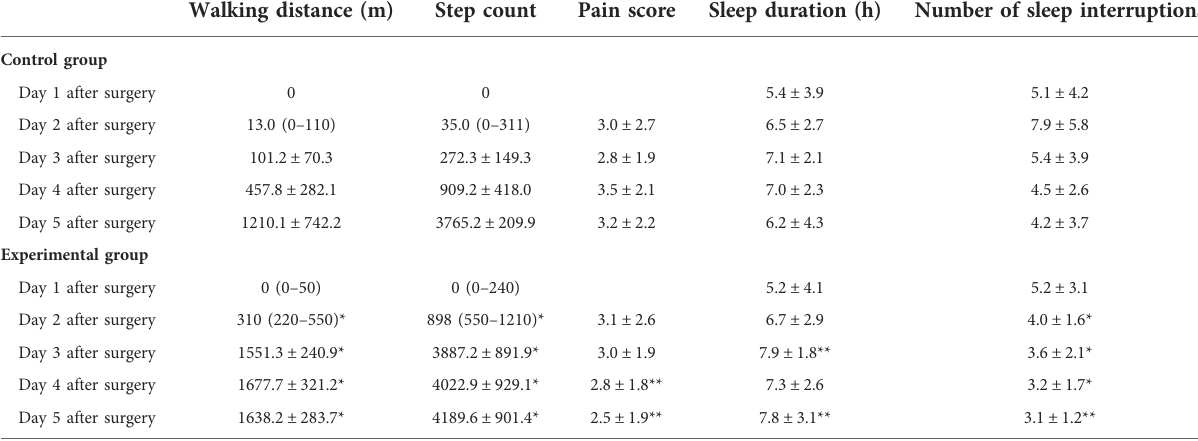
TABLE 2 Postoperative walking distance, pain scores and sleep quality in the two groups.